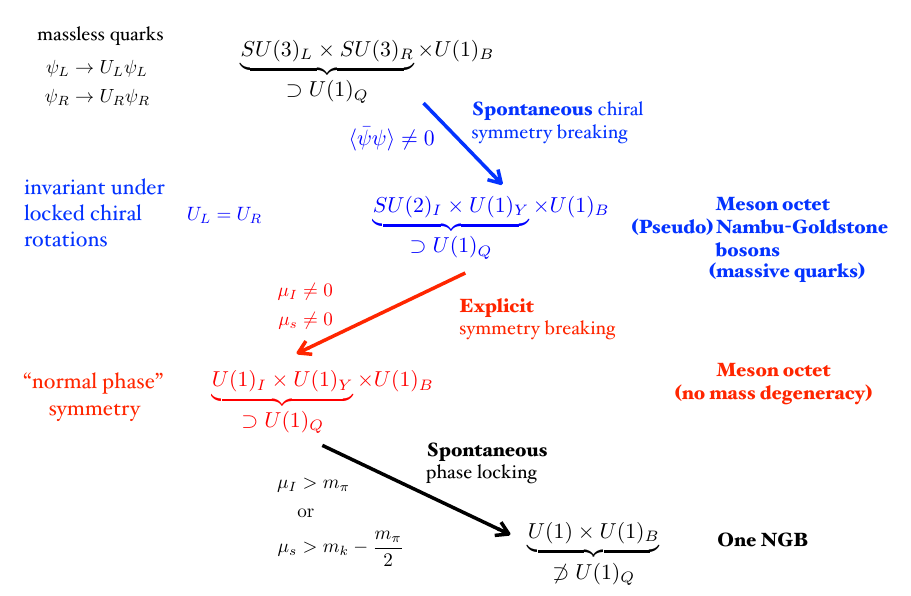
Figure 3. Symmetry breaking path of three flavor quark matter; the arrows indicate the various symmetry breakings. On the right we report the emergent low-energy degrees of freedom. The normal phase is defined by the corresponding symmetry group, see Equation (35). See the text below for a through description of the symmetry